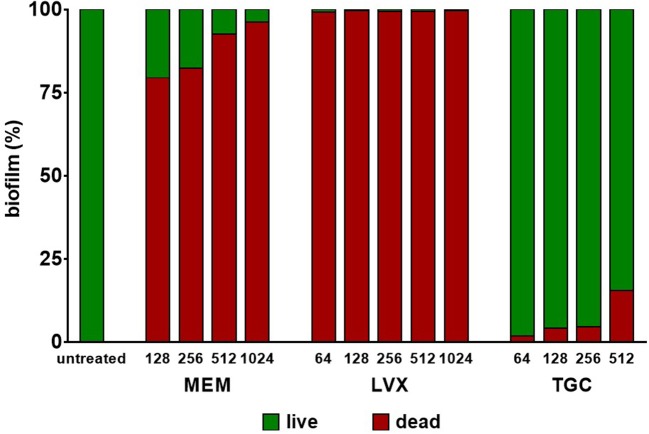
Activity of antibiotics against preformed biofilm by Myroides odoratimimus in collagen gel matrix. Biofilm was allowed to grow in collagen gel matrix following 7 day-incubation at 37°C in SWF medium at pH 7.2 and in the presence of glucose 12.5 mM. Biofilm was then exposed for 24 h to several concentrations of meropenem (MEM: 128–1,024 μg/ml), levofloxacin (LVX: 64–1,024 μg/ml) or tigecycline (TGC: 64–512 μg/ml). Biofilm's viability was evaluated by viable cell count and expressed as percentage compared to control (untreated) samples. The proportion of dead cells is shown in red, whereas that of live cells in green.